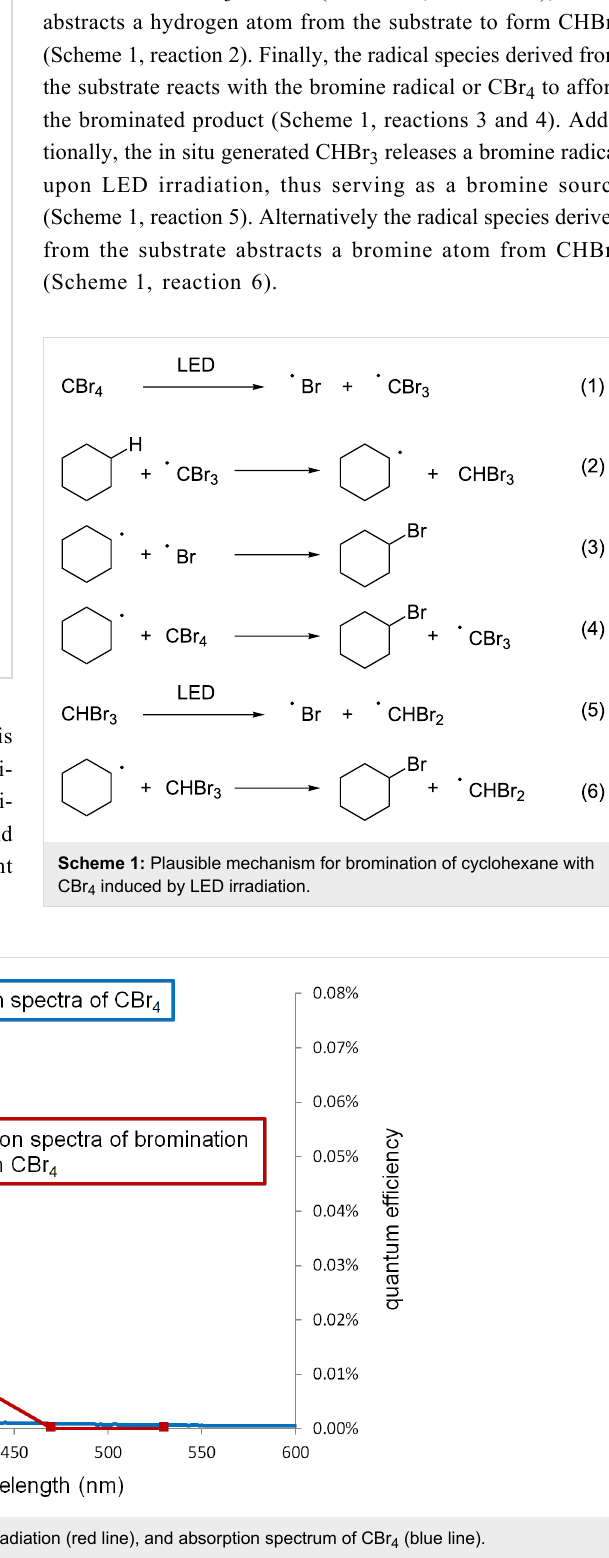
Table 2: Bromination of other substrates using CBr 4 under LED irradi- ation. a